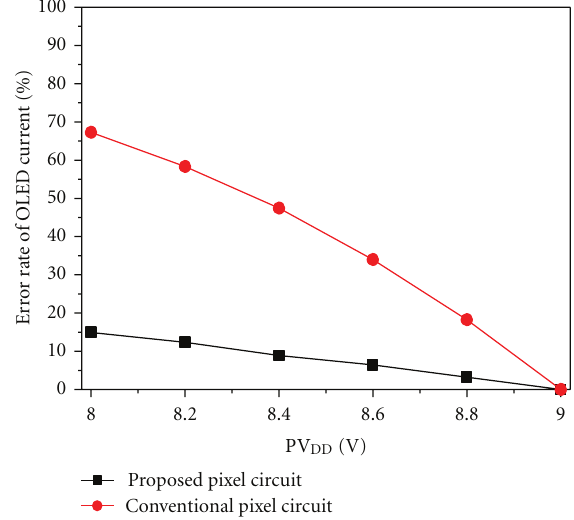
Figure 8: Comparison of current variation versus PV DD drop for the conventional 2T1C pixel circuit and the proposed pixel